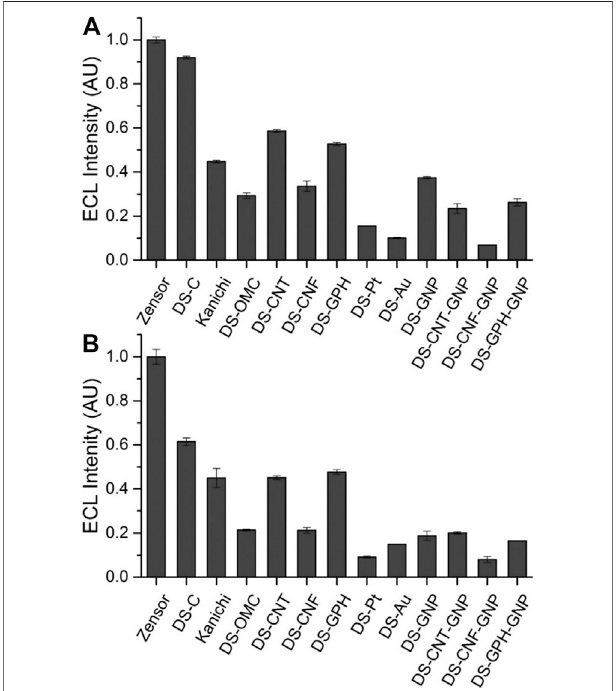
FIGURE 3 | ECL intensities from various SPEs relative to Zensor, conducted in pH 7.5 PBS, 100 mM TPrA. (A) 1 × 10 − 7 M [Ru(bpy) 3 ] 2+ . (B) 1 × 10 − 8 M [Ru(bpy) 3 ] 2+ (n (cid:2) 3). Intensities are corrected for the difference in geometric working electrode area (Zensor and Kanichi SPEs 3 mm working electrode diameter, DS 4 mm working electrode diameter).